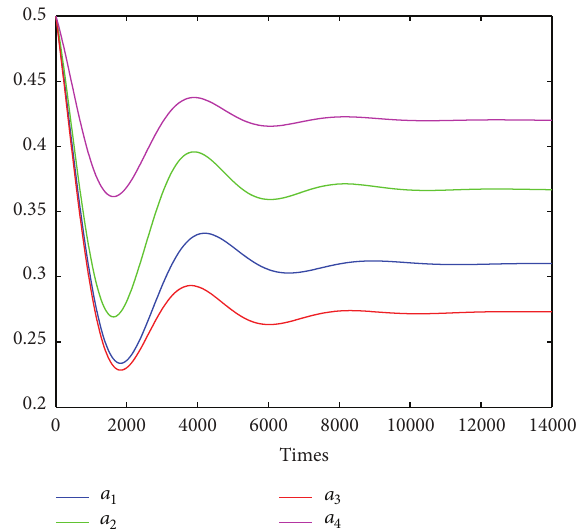
Figure 6: Estimated parameters of memristor chaotic oscillator system (7).